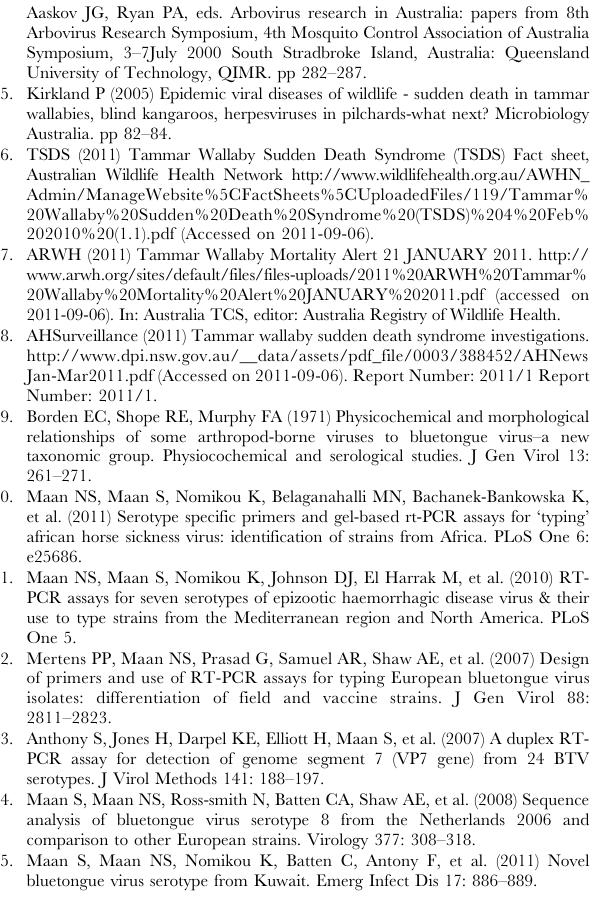
Table S1 Nucleotide accession numbers for sequences used in phylogenetic analysis. Table S2 Percent aa identity of EUBV, TILV and PATAV Polymerase (Pol) protein with other orbiviruses. Table S3 Identity levels in the outer-core protein VP7(T13) of EUBV, TILV and PATAV compared to other Orbiviruses. Table S4 Nuclear localization signals (NLS) in NS4 of Eubenangee, Tilligerry and Pata